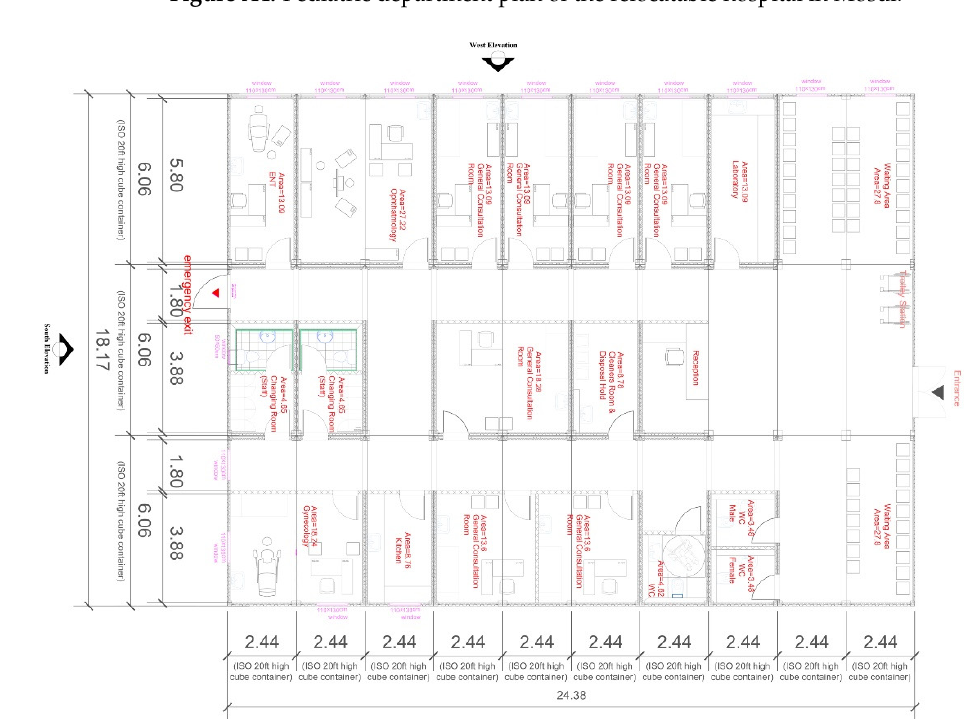
Figure A4. Pediatric department plan of the relocatable hospital in Mosul.